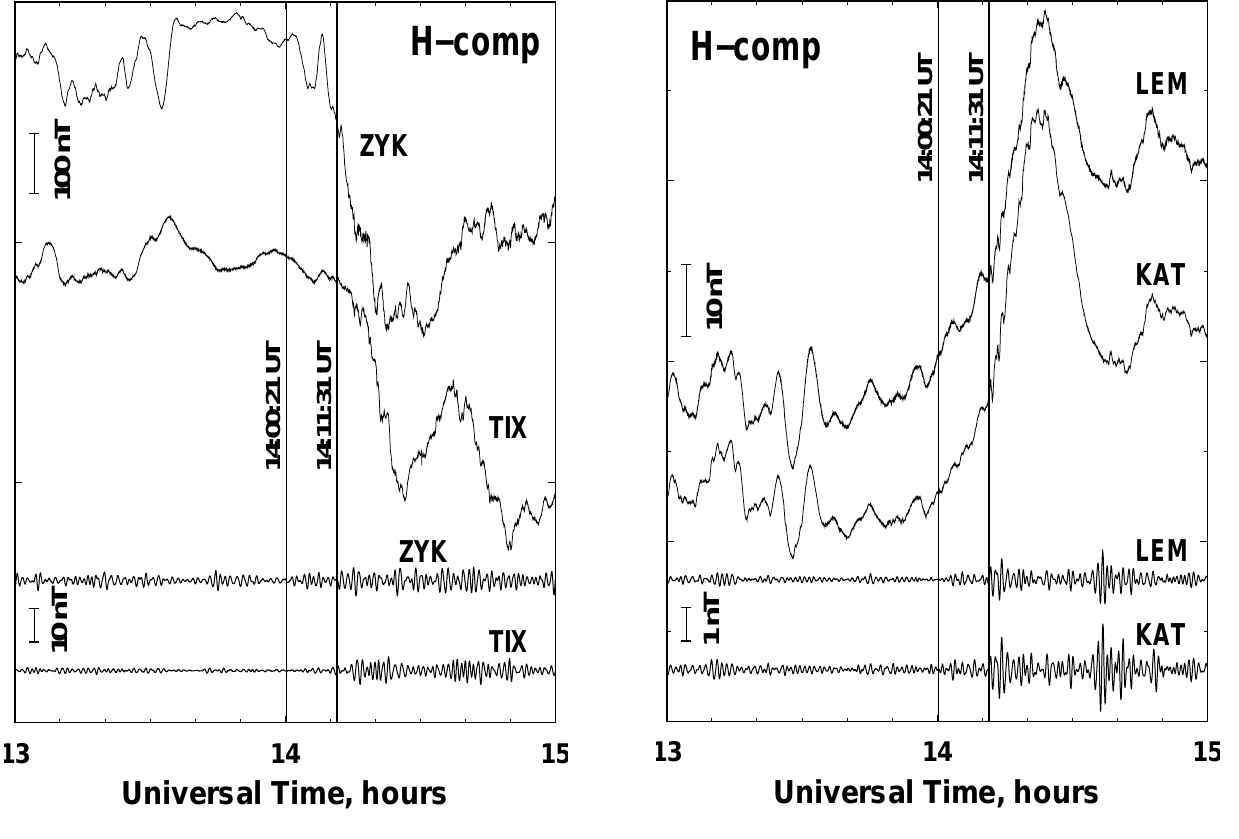
Fig. 8. One-second ground magnetometer data from the LEM and KAT stations in the 210MM